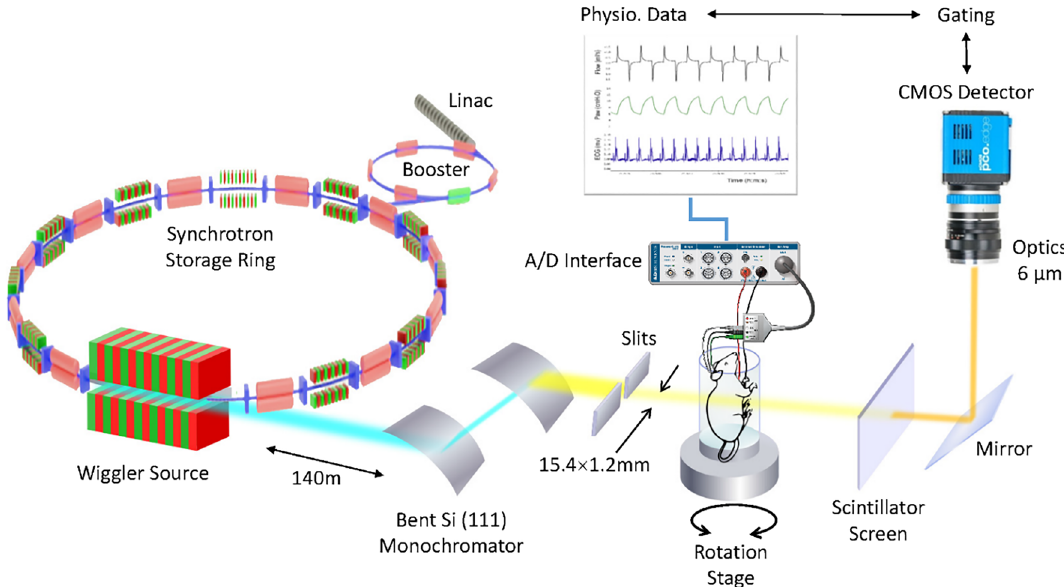
Figure 1. Dynamic 3D microscopy of rat lung using a synchrotron X-ray source. High-intensity coherent X-rays generated from electrons orbiting in a storage ring, are rendered monochromatic using bent silicon crystal optics, and detected by a PCO Edge 5.5 camera coupled to a Cerium-doped Lutetium Aluminium Garnet (LuAG:Ce) scintillator and optics yielding an isotropic pixel size of 6 µm 3 . The anesthetized rat is mechanically ventilated while the electrocardiogram and respiration are monitored and